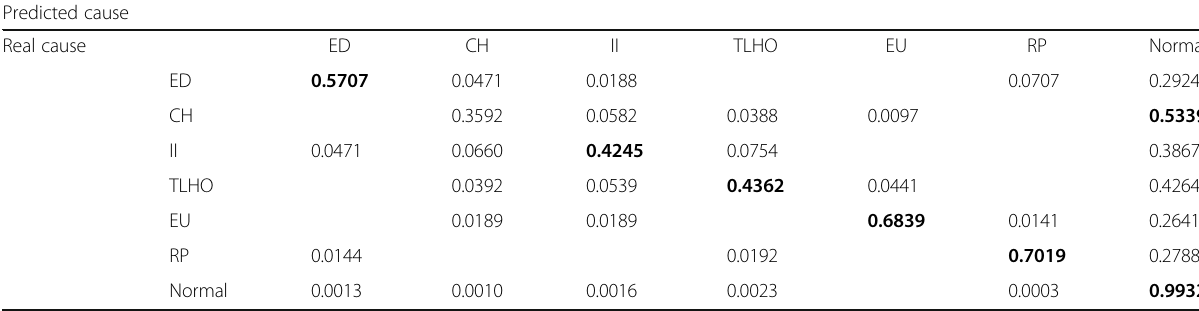
Table 4 Normalized confusion matrix of AdaBoostRBFSVM method with optimal parameter values Predicted cause Real